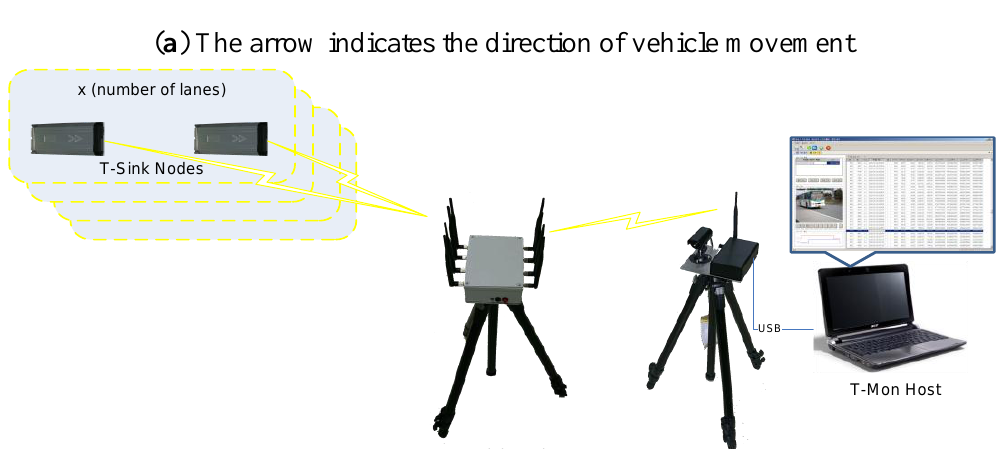
( b ) T-Sensor nodes in each lane use a unique frequency